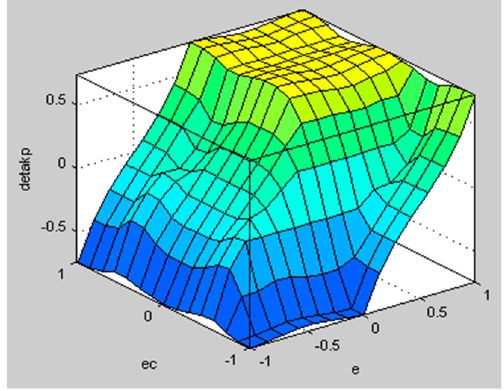
Figure 9. Fuzzy surface of ∆ k P .